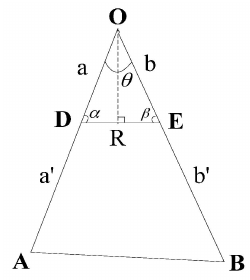
Figure 4. Diagram of